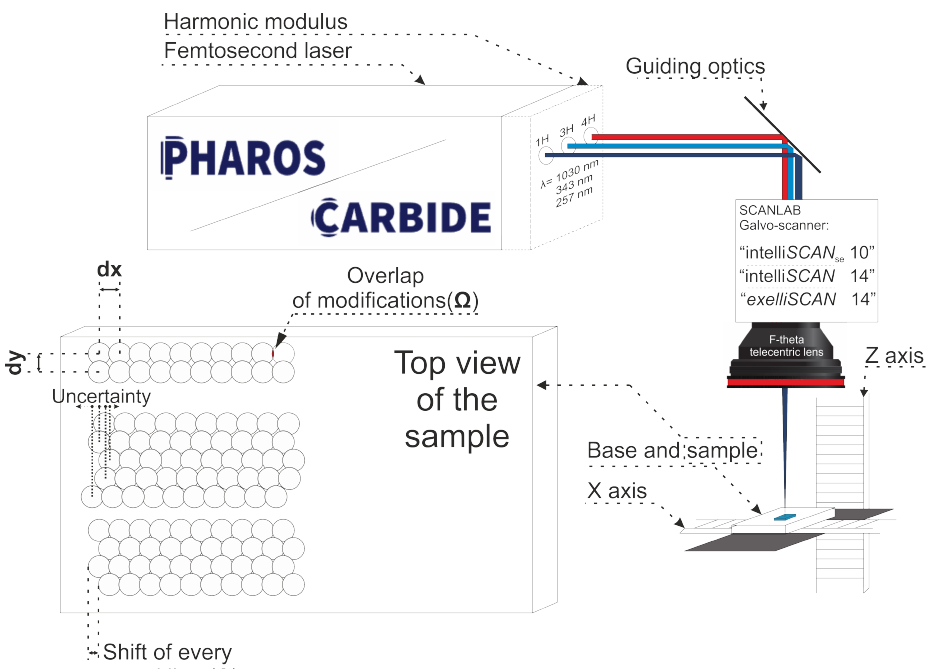
Figure 2. Principle scheme of the laser system used in the study. Femtosecond lasers “Carbide“ or “Pharos“ was used as the laser source. The beam was guided via dielectric mirrors of high reflectivity for a specific wavelength. The beam was scanned on the surface of the sample using the SCANLAB galvo-scanner and f-theta lens combination. The sample was placed on two axes allowing movement in x and y directions. In the left bottom part of the picture, the top view of the sample and an explanation of different notations used in the study are presented. dx —distance between single modifications in x direction, dy —distance in y direction, Ω —overlap of modifications, ∆ —shift of every second line.